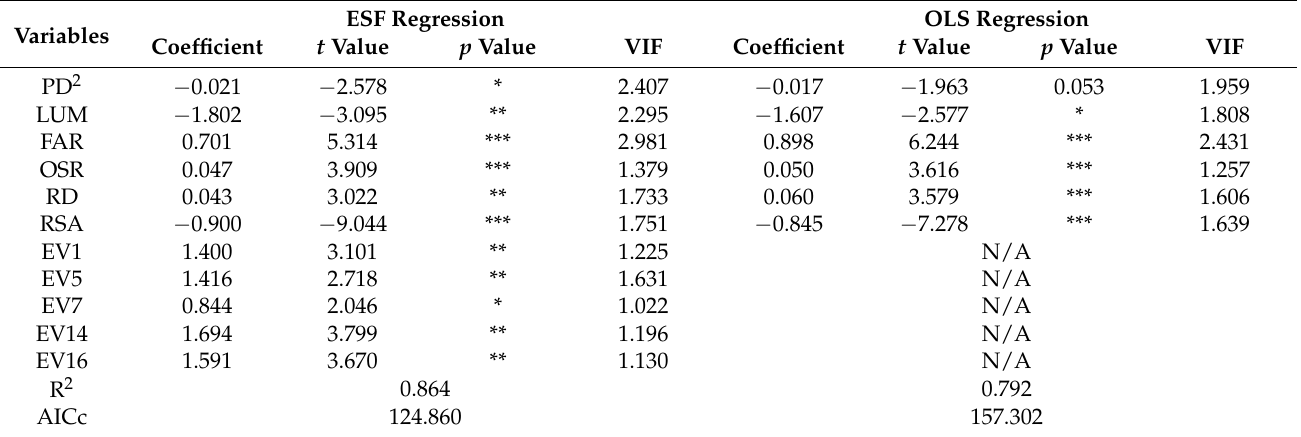
Table 9. Comparison of OLS regression and ESF regression (ln(Cult_V) as the dependent variable).